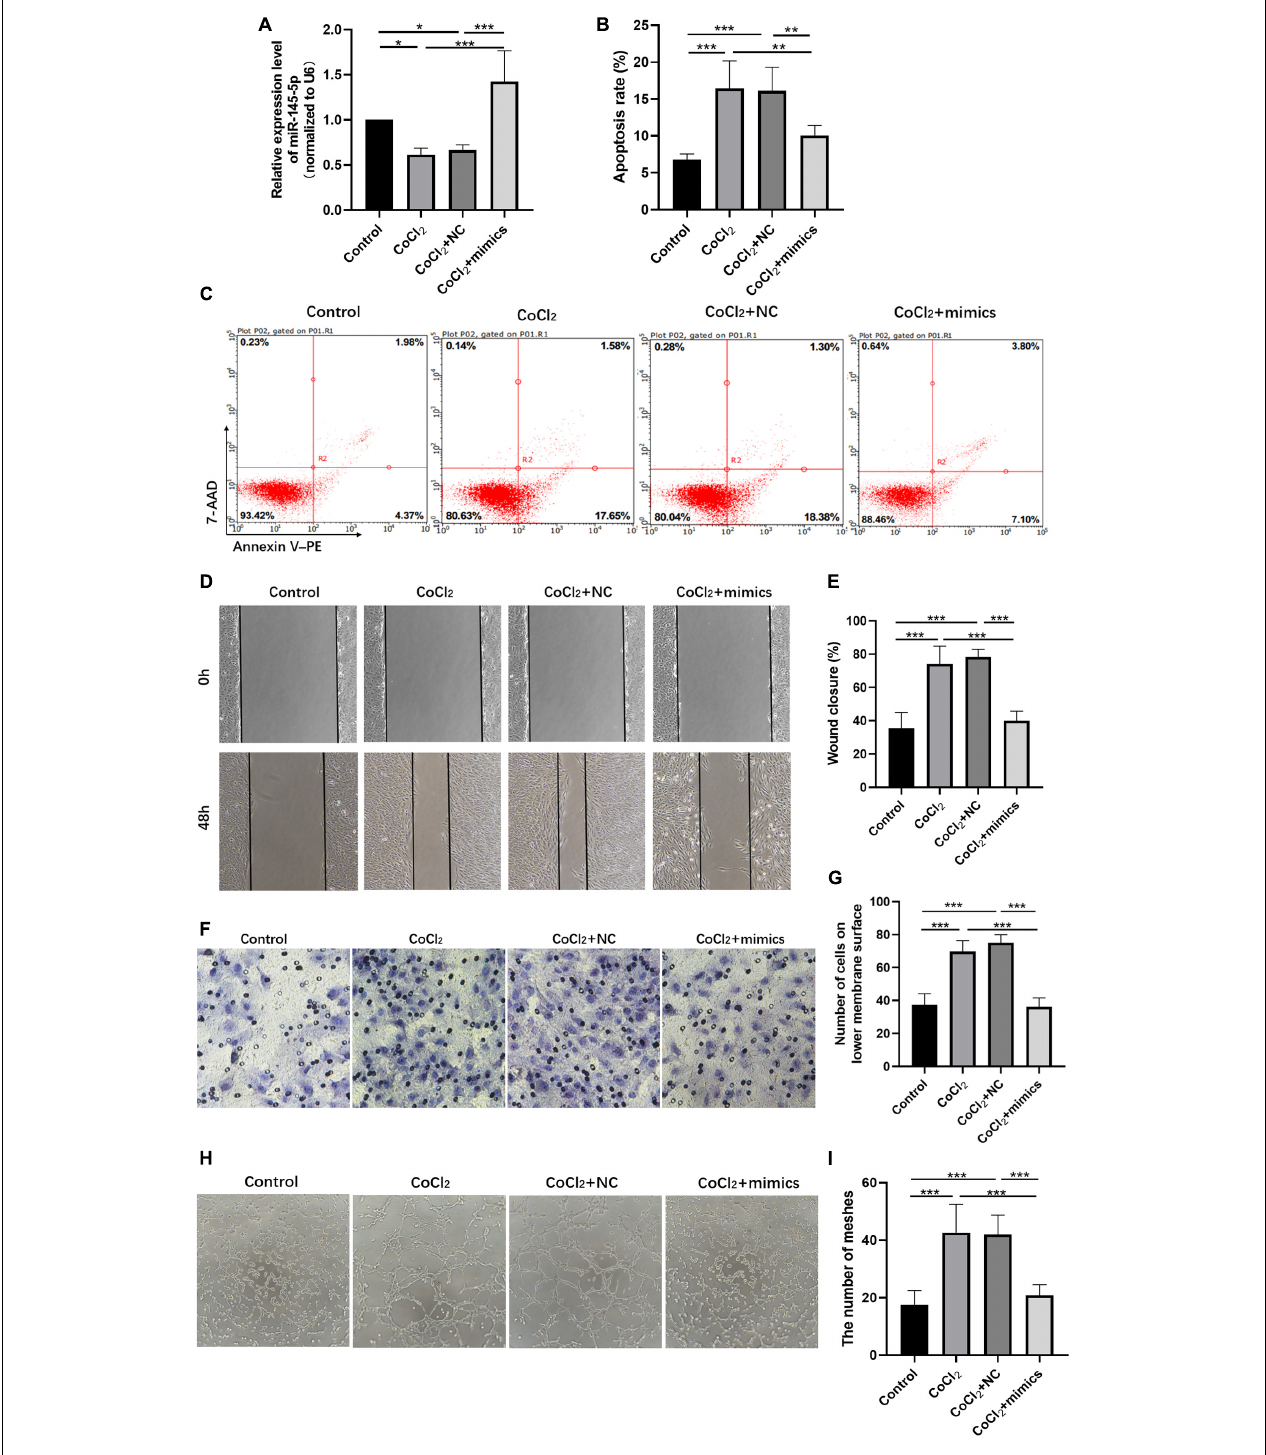
FIGURE 4 | Overexpressing miR-145-5p inhibits apoptosis, migration, and angiogenesis in HRECs induced by hypoxia. (A) MiR-145-5p expression level (mean ± SD, n = 5). * P < 0.05. (B) Flow cytometry results showing the percentage of apoptotic cells (mean ± SD, n = 5). *** P < 0.001. (C) Results of flow cytometry with cells labeled with Annexin-PE and 7-Aminoactinomycin D (7-AAD). (D) Results of the wound healing assay, 100 × magnification. (E) Quantitation of results from the wound healing assay in (D) (mean ± SD, n = 5). *** P < 0.001. (F) Results of transwell migration assay, 200 × magnification. (G) Quantitation of results from the transwell migration assay in (F) (mean ± SD, n = 5). *** P < 0.001. (H) Results of tube formation assay, 100 × magnification. (I) Comparison of the number of meshes in different treatment groups (mean ± SD, n = 5), *** P < 0.001, ** P < 0.01.